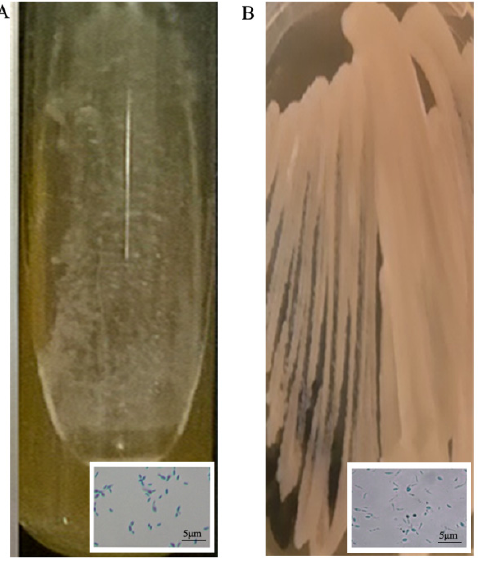
Figure 1. Morphological differences between the Sporothrix strain CMRVS 40433 in yeast phase before ( A ) and after ( B ) cryopreservation at − 80 °C for 24 months. Sporothrix brasiliensis strain CMRVS 40433, for instance, which previous to preservation presented a brown colony and pigmented conidia (Figure 2A,B), after storage showed a white colony and hyaline conidia (Figure 2C,D).